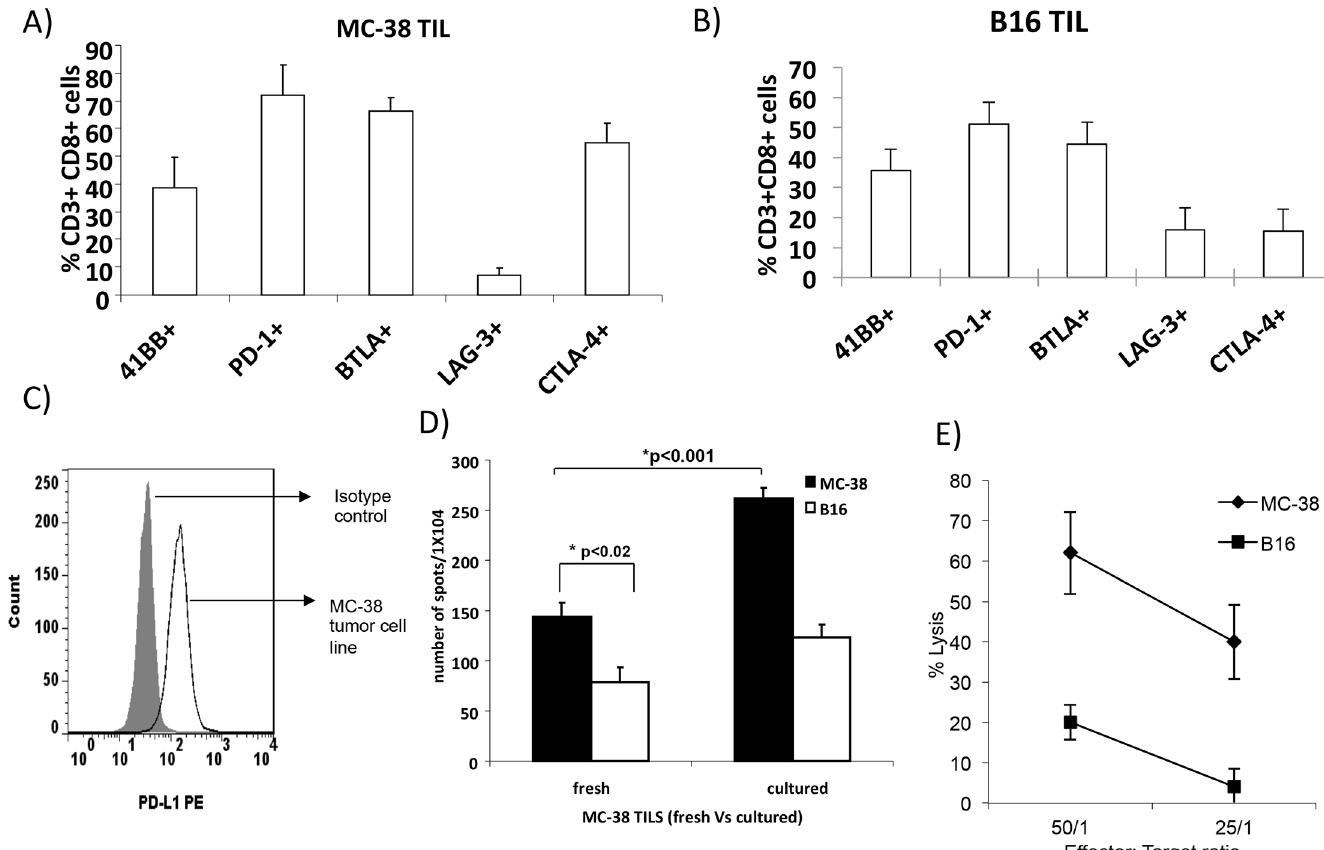
Fig 2. Expression of immune checkpoint receptors on MC-38 and B16 TIL. A&B) Flow cytometry analysis of PD-1, CTLA-4, BTLA, and LAG-3 expression on MC-38 (A) and B16 (B) TIL; C) PD-L1 expression on MC-38 tumor cells; D) fresh or cultured MC-38 TIL were co-cultured with MC-38 or irrelevant B16 tumor cells and incubated for 48 hours at 37°C. The number of IFN- γ producing cells in response to stimulation was evaluated in an ELISPOT assay. The number of spots was counted in triplicates and calculated using an automatic ELISPOT counter; E) TIL was cultured with 51 Cr labeled MC-38 or B16 tumor cells at 50:1 and 25:1 effector to target ratios. After 5 hours, the percentage of specific 51 Cr release was determined by the following equation: (experimental cpm − spontaneous cpm)/ (total cpm incorporated − spontaneous cpm) × 100. All determinations were done in triplicate, and the SE of all assays was calculated and was typically 5% of the mean or